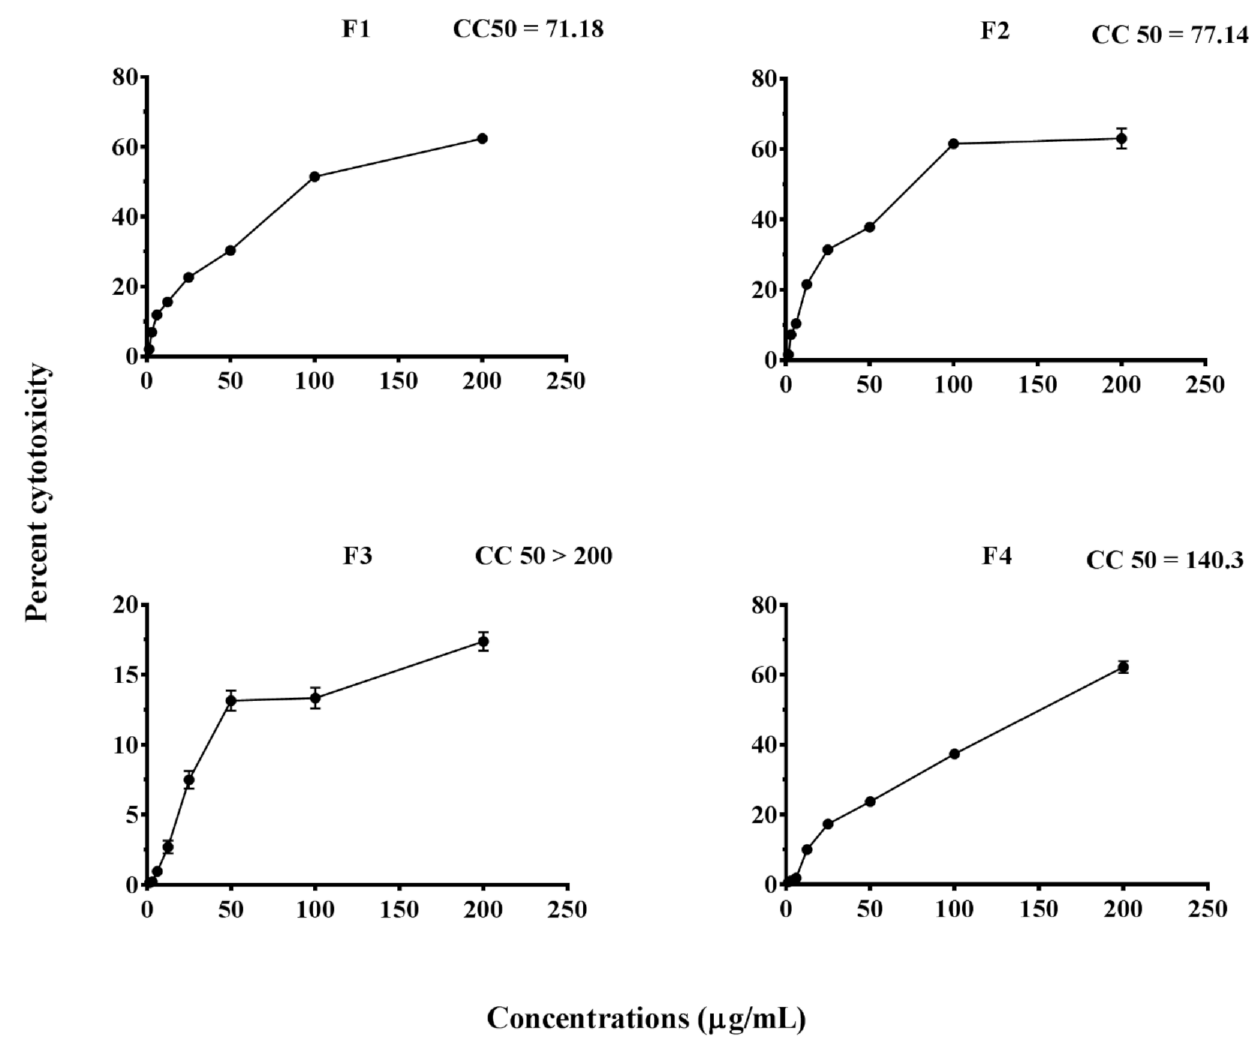
Figure 4. Cell cytotoxicity of different formulations against Vero E6 cells at various concentrations using an MTT assay. All the values are expressed as mean ± SEM ( n =